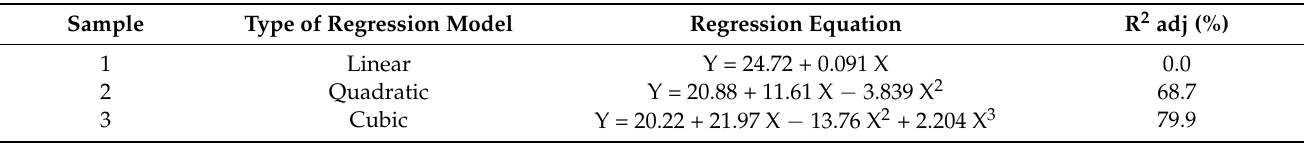
Table 9. The orthogonal polynomial regression model for the compressive strength of the mortar with the addition of 3% OPS-activated charcoal and OPEFB hydrochar fibre.